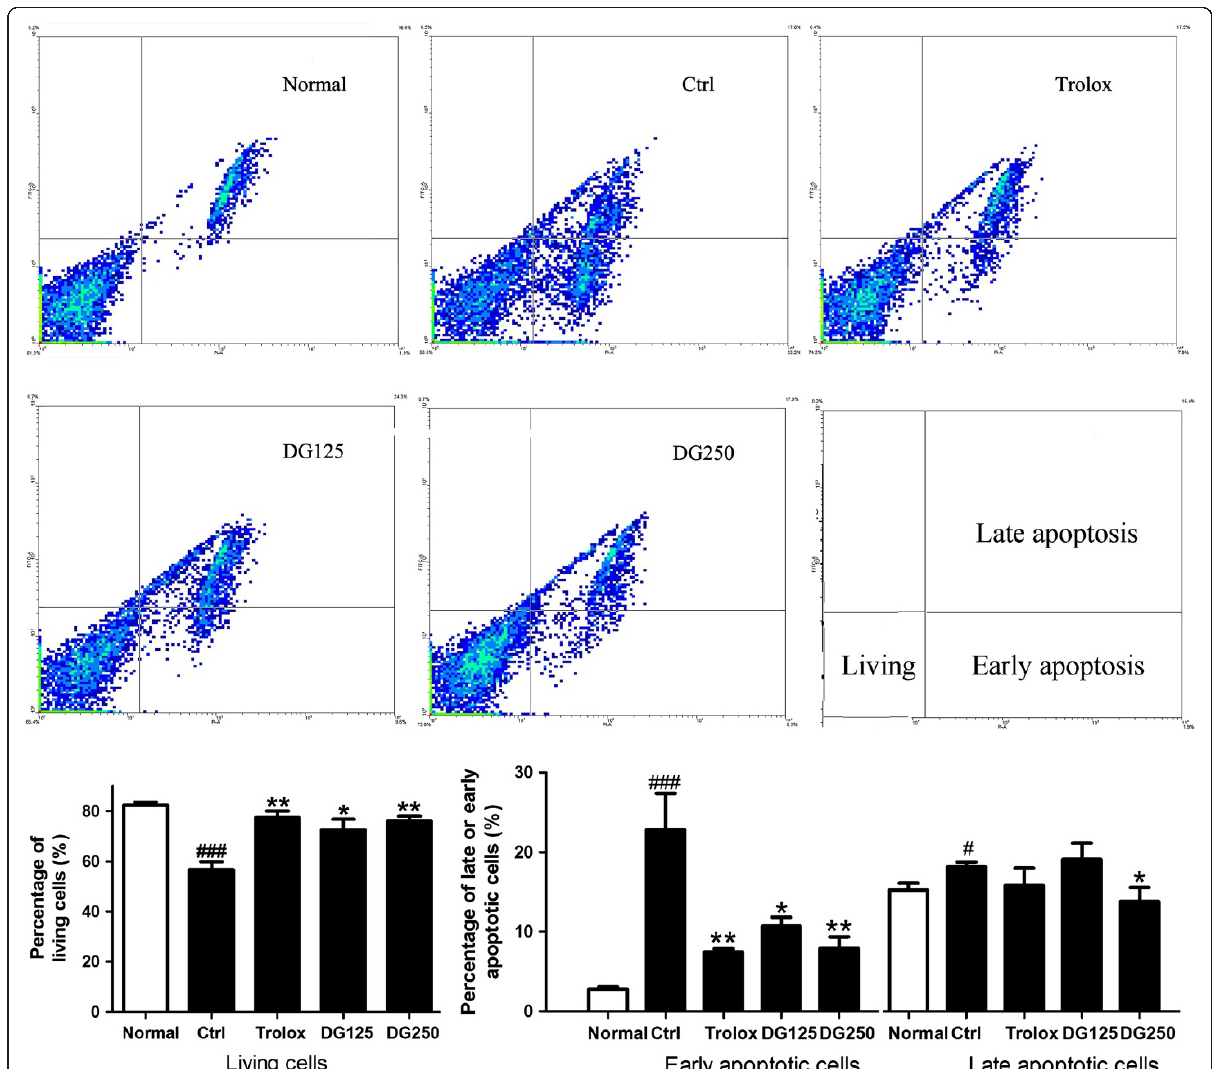
Figure 4 The effect of DG on H/R-induced apoptosis in H9c2 cells. After H9c2 cells were challenged by H/R in the presence or absence of DG (125 and 250 μ g/ml) or trolox (20 μ M), apoptotic cells were analyzed by Annexin V/PI staining. The data were expressed as mean ± S.E.M. Three independent experiments were performed. # p < 0.05 and ### p < 0.001 indicated the groups with significant difference when compared to the normoxic group. *p < 0.05 and **p < 0.01 indicated the groups with significant difference when compared to the control